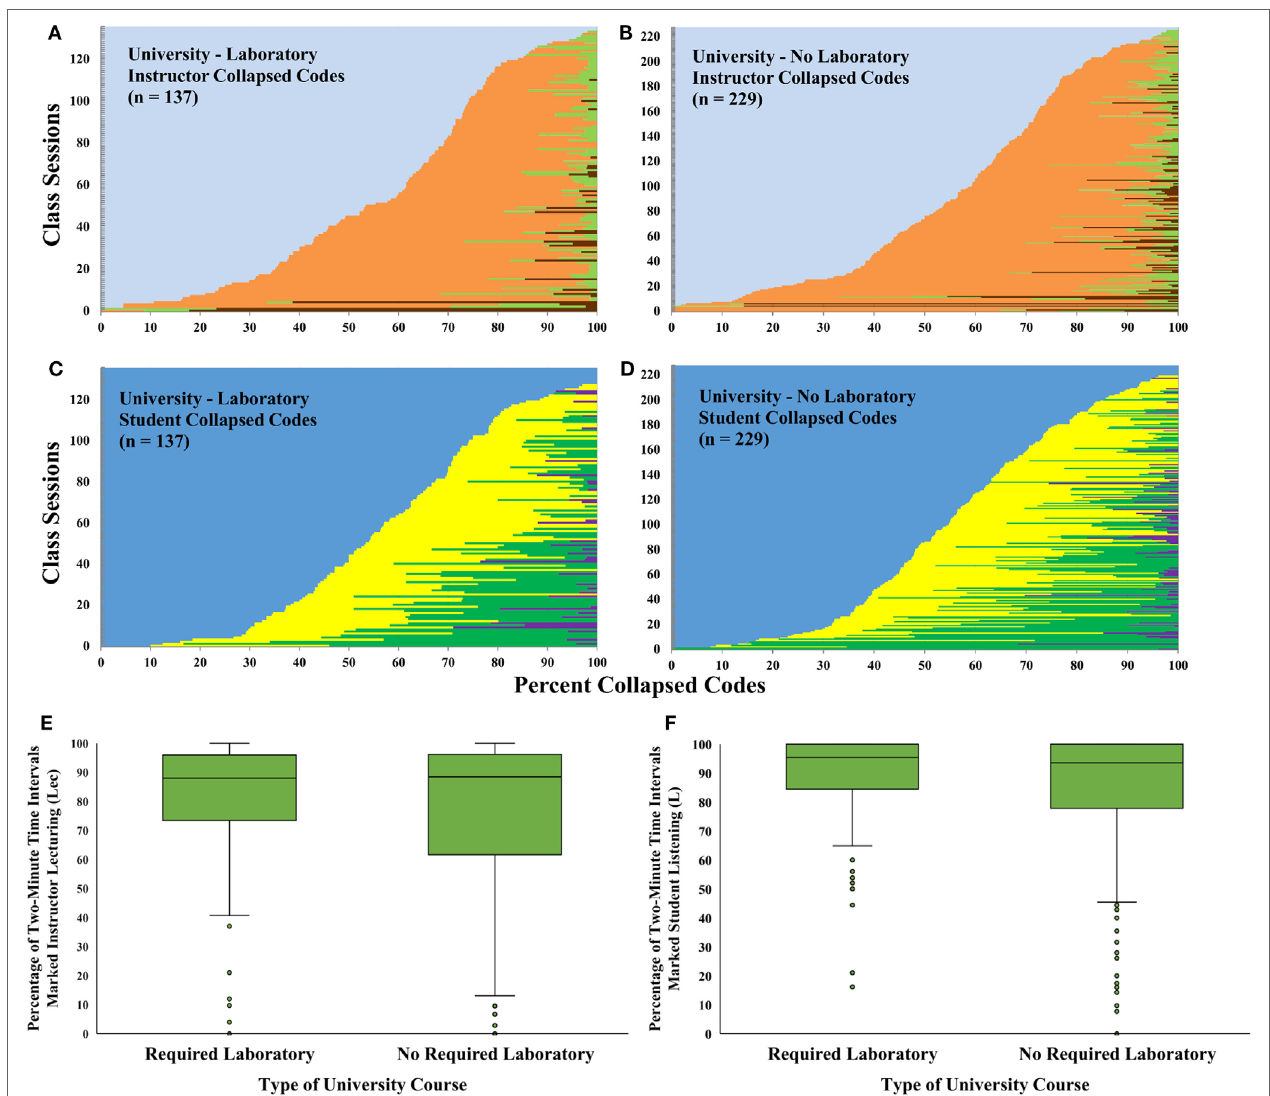
FigUre 11 | A comparison of university classes with and without a required laboratory section. Percentage of instructor collapsed Classroom Observation Protocol for Undergraduate STEM (COPUS) codes for all university class observations (a) with required laboratory sections and (b) with no required laboratory section ordered by percent Instructor Presenting. Percentage of student collapsed COPUS codes for all university class observations (c) with required laboratory sections and (D) with no required laboratory section ordered by percent Student Receiving. Each horizontal bar represents a different class session. (e) Box-and-whisker plots showing the median and variation of the COPUS code Instructor Lecturing (Lec) for the two types of university classes. (F) Box-and-whisker plots showing the median and variation of the COPUS code Student Listening for the two types of university classes. The line in the middle of the box represents the median percentage of 2-min time intervals. Boxes represent the interquartile range, whiskers represent 1.5 times the interquartile range, and data points not included in 1.5 times the interquartile range are shown with dots. There are no significant differences in Instructor Lec or Student Listening medians for university classes with and without a required laboratory section (Mann–Whitney U , Lec χ 2 = 16,526.5, Listening χ 2 = 16,733.0, N = 366, p > 0.05 in both